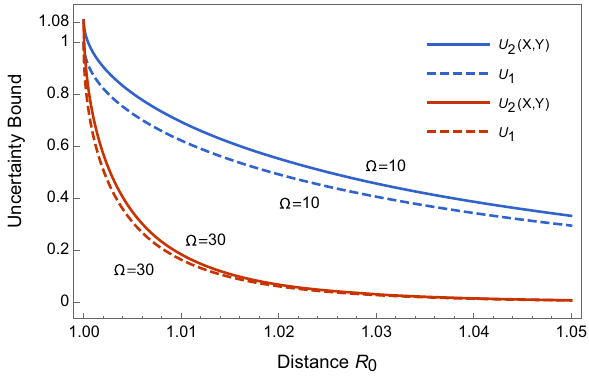
is always better than U 1 2